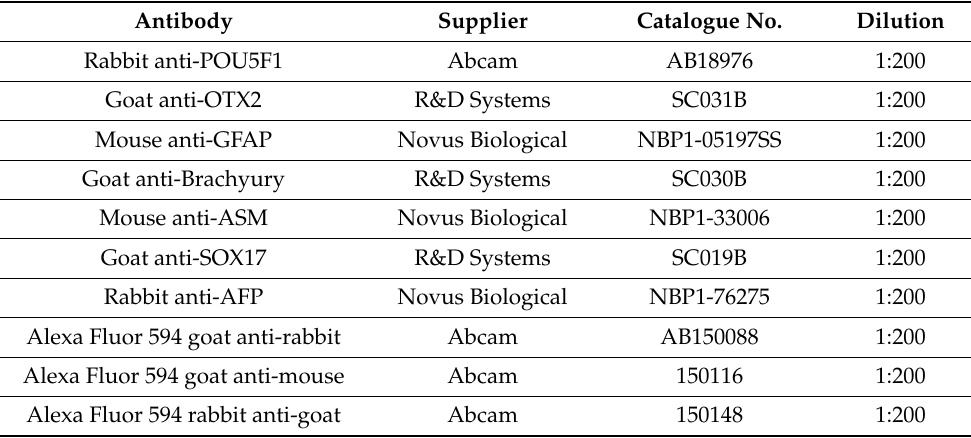
Table 1. Antibodies used for immunofluorescence and immunocytochemistry.